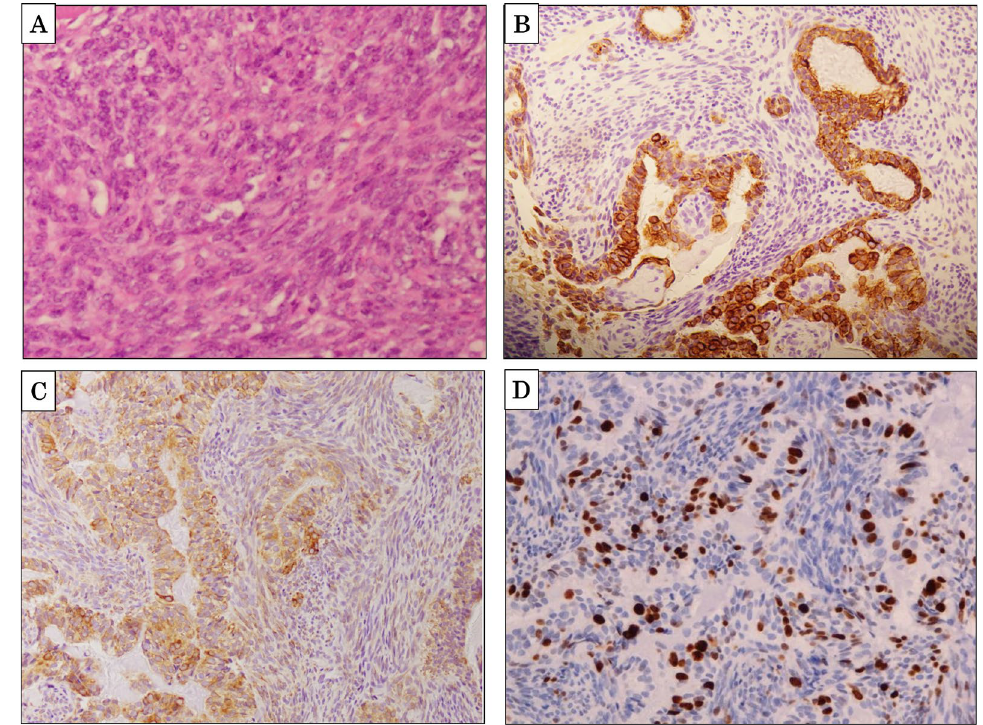
Fig. 2 A Histological findings of the specimen revealed a biphasic-type tumor consisting of both epithelial- and spindle-shaped cells. Immunohistochemistry for cytokeratin ( B ), Bcl-2 ( C ), and MIB-1 ( D